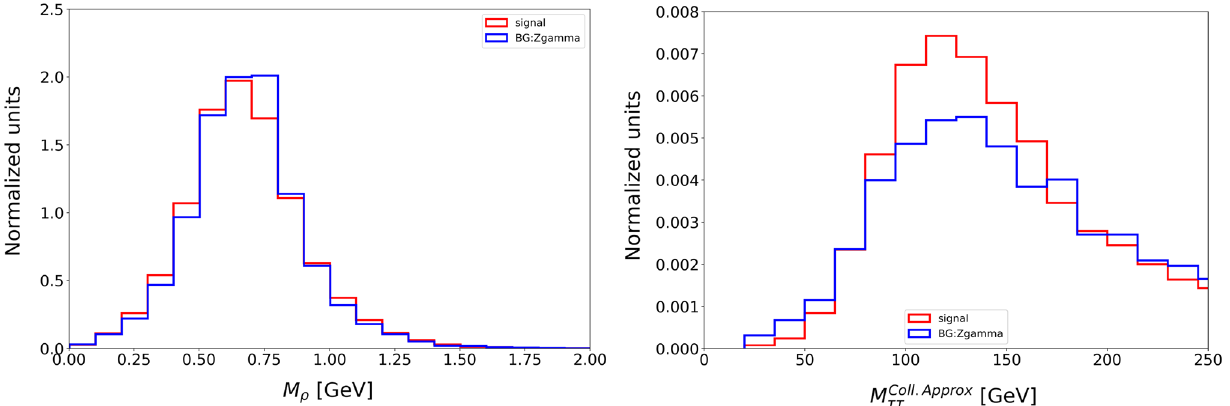
Fig. 7 Left panel displays the distribution of the rho mass computed from the charged pions and the neutral pions. In the right panel we show the reconstructed τ pair invariant mass using the collinear approximation. Clearly the collinear approximation works well in getting the Higgs boson